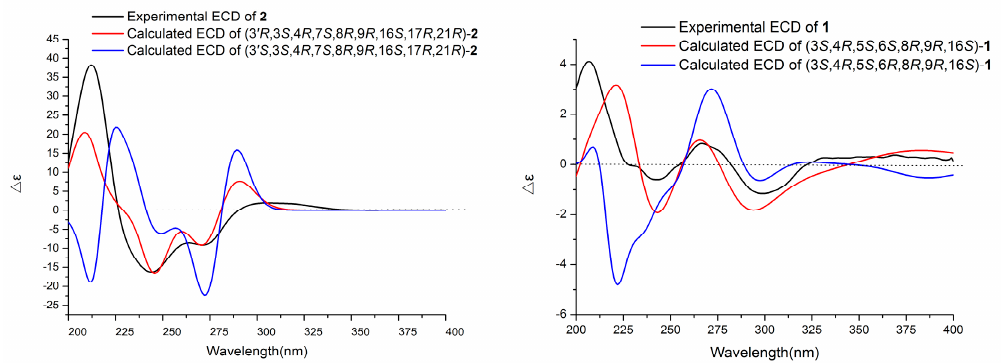
Figure 4. Experimental and calculated ECD spectra of Compounds 1 and 2 .